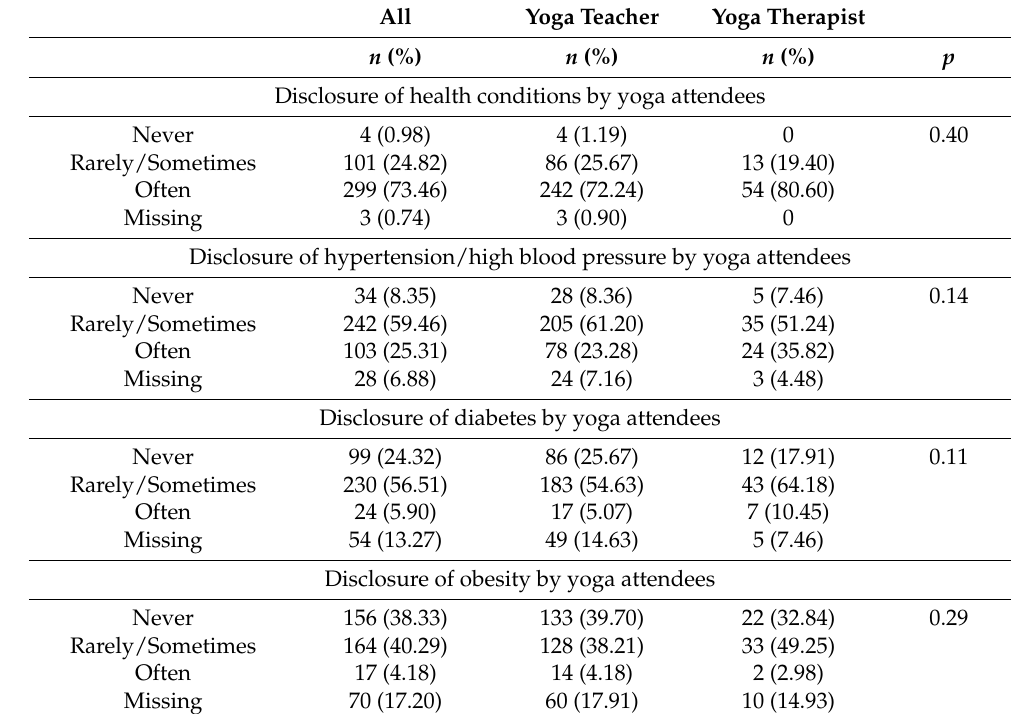
Table 4. Yoga providers’ awareness of health conditions and their training on